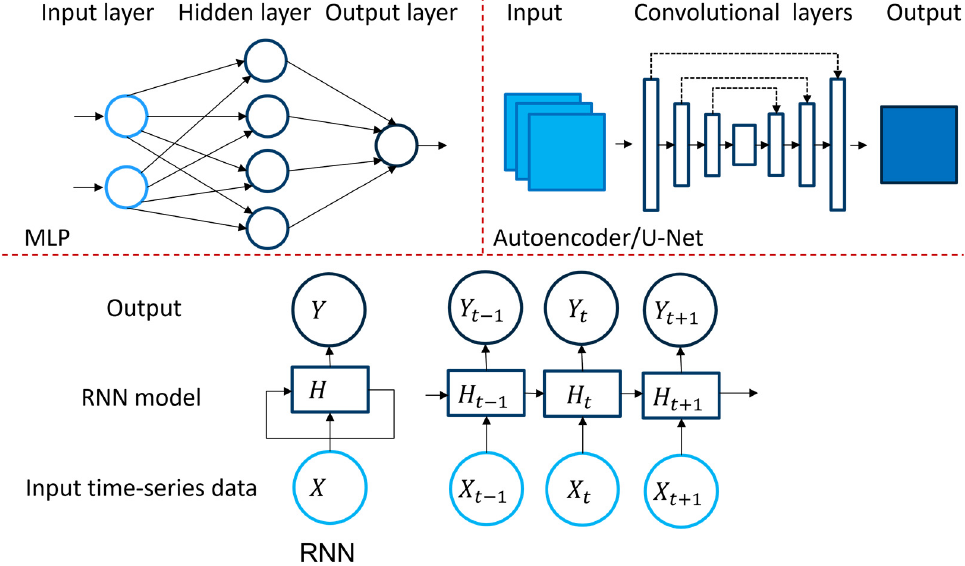
Figure 3. Schematic of some popular DL models used in flood modeling, MLPs can be used for both classification and regression and consist of input, output and hidden fully connected layers, Autoencoders: these models consist of two main parts to encode and decode the data, Recurrent Neural networks (RNN) are designed to extract best out of time-series data.